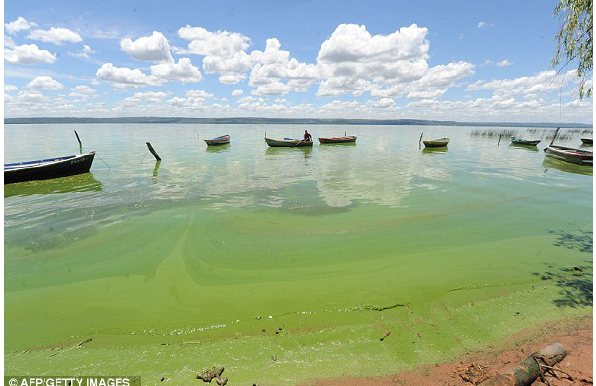
Figure 1. Cyanobacteria effects on the Lake shore. The contaminated water has a characteristic intense green color and gives off an unpleasant